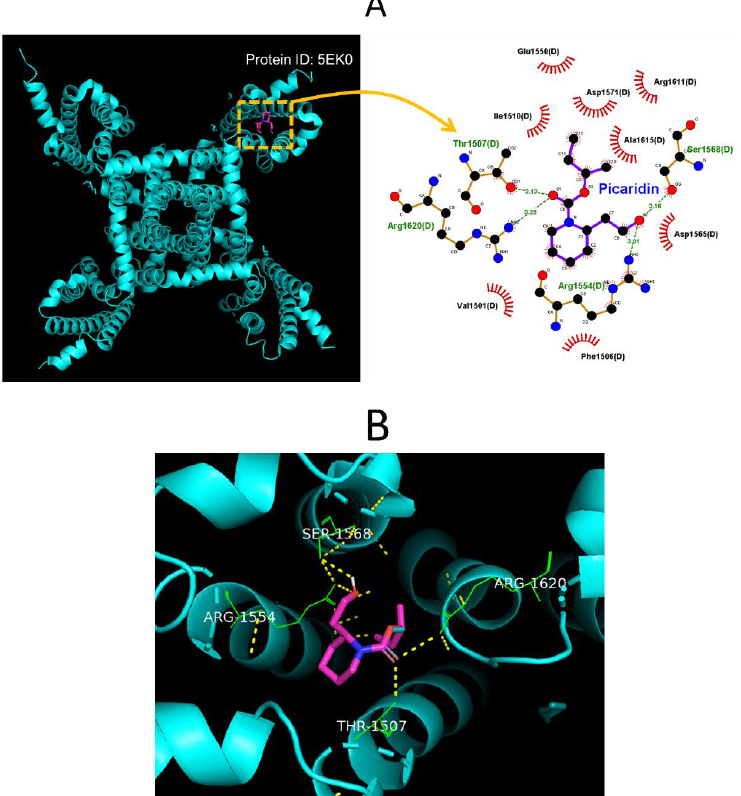
Figure 8. Results on molecular docking between the hNa V 1.7 channel and the picaridin molecule. The protein structure of hNa V 1.7 was obtained from RCSB (Research Collaboratory for Structural Bioinformatics) PDB (PDB ID: 5EK0), while the picaridin molecule was from PubChem (Compound CID: 125098 [3D conformer]). The structure about the hNa V 1.7 channel was docked by the picaridin molecule with PyRx software ( http://pyrx.sourceforge.io/ ) (accessed on 18 August 2022). ( A ) Diagram of the interaction between the hNa V 1.7 channel and the picaridin molecule created from the LigPlot + program ( http://www.ebi.ac.uk/thornton-srv/software/LIGPLOT/ ) (accessed on 18 August 2022). Of notice, the red arcs on which small bars radiated toward the ligand (i.e., picaridin) represent hydrophobic interactions, while the green dotted lines residing in amino-acid residue (i.e., Thr1507(D), Arg1554(D), Ser1568(D), and Arg1820(D)) represent formation of hydrogen bonds. ( B ) Expanded graph for two-dimensional interaction sketch illustrating the predicted interactions of picaridin with residues (green color) in which hydrogen bonds are formed (indicated in yellow dotted line). The center in the diagram indicates the picaridin molecule.